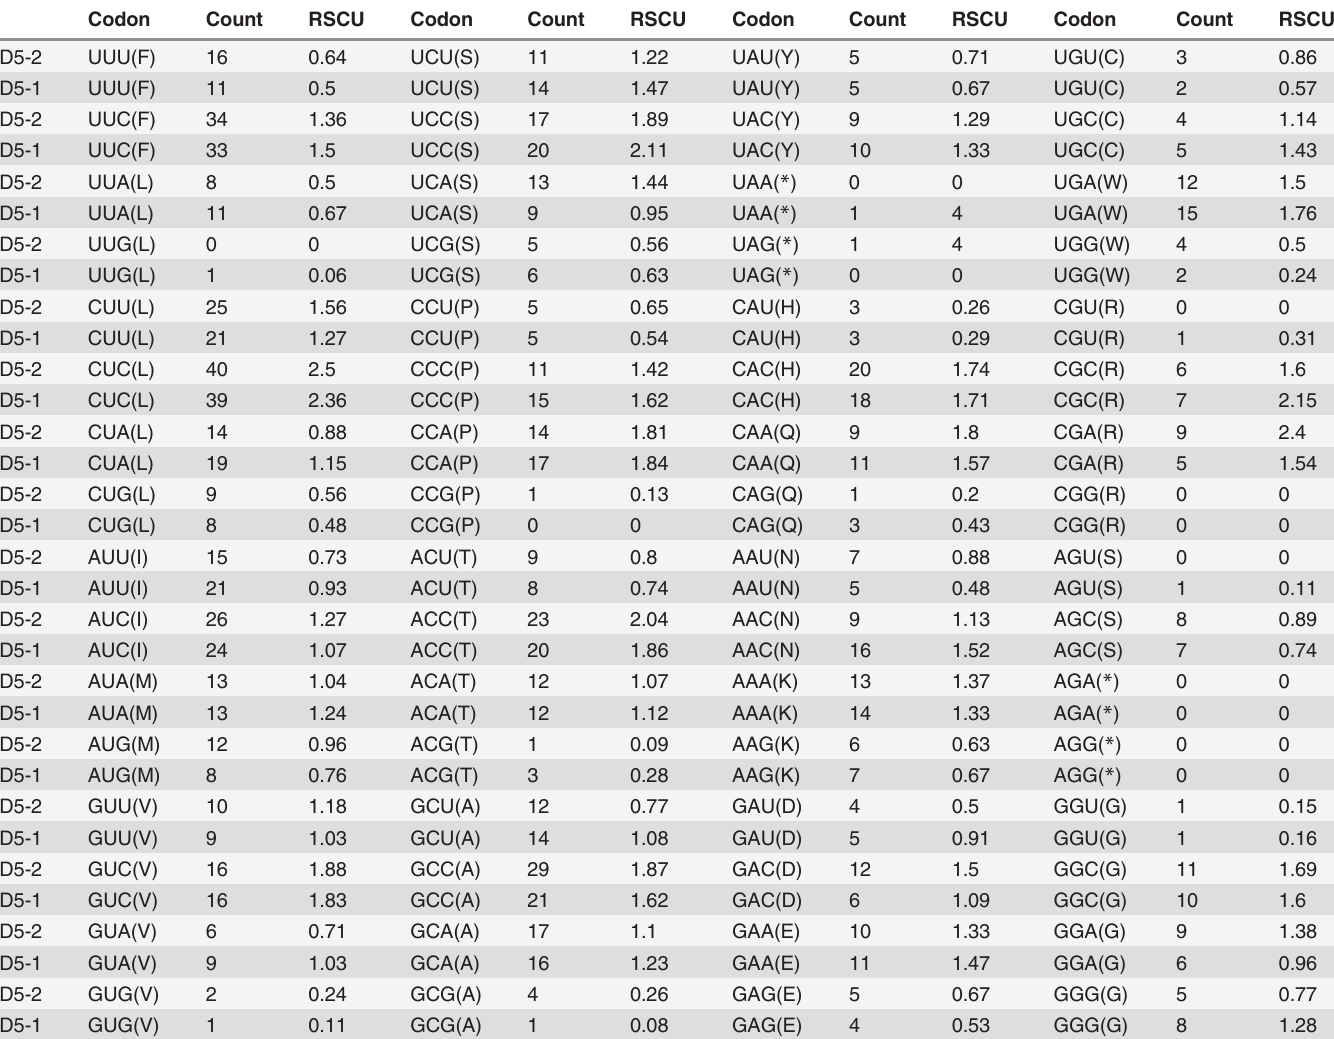
Table 3. The RSCU in two different ND5 genes of H . rugulosus (BT).